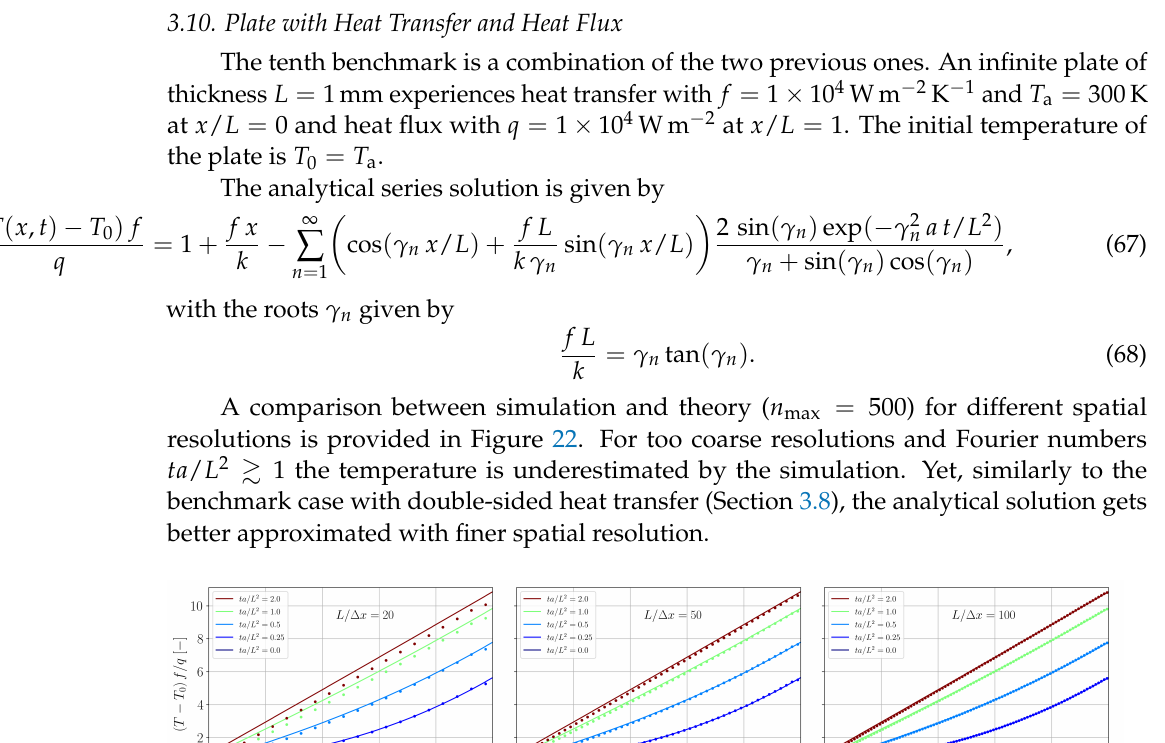
Figure 21. Comparison of simulation results (dots) and analytical solution (solid lines, Equation (65)) for the temperature distribution in a plate with double-sided heat flux. The spatial resolution is varied between L / ∆ x = 20 ( a ), L / ∆ x = 50 ( b ) and L / ∆ x = 100 ( c ).